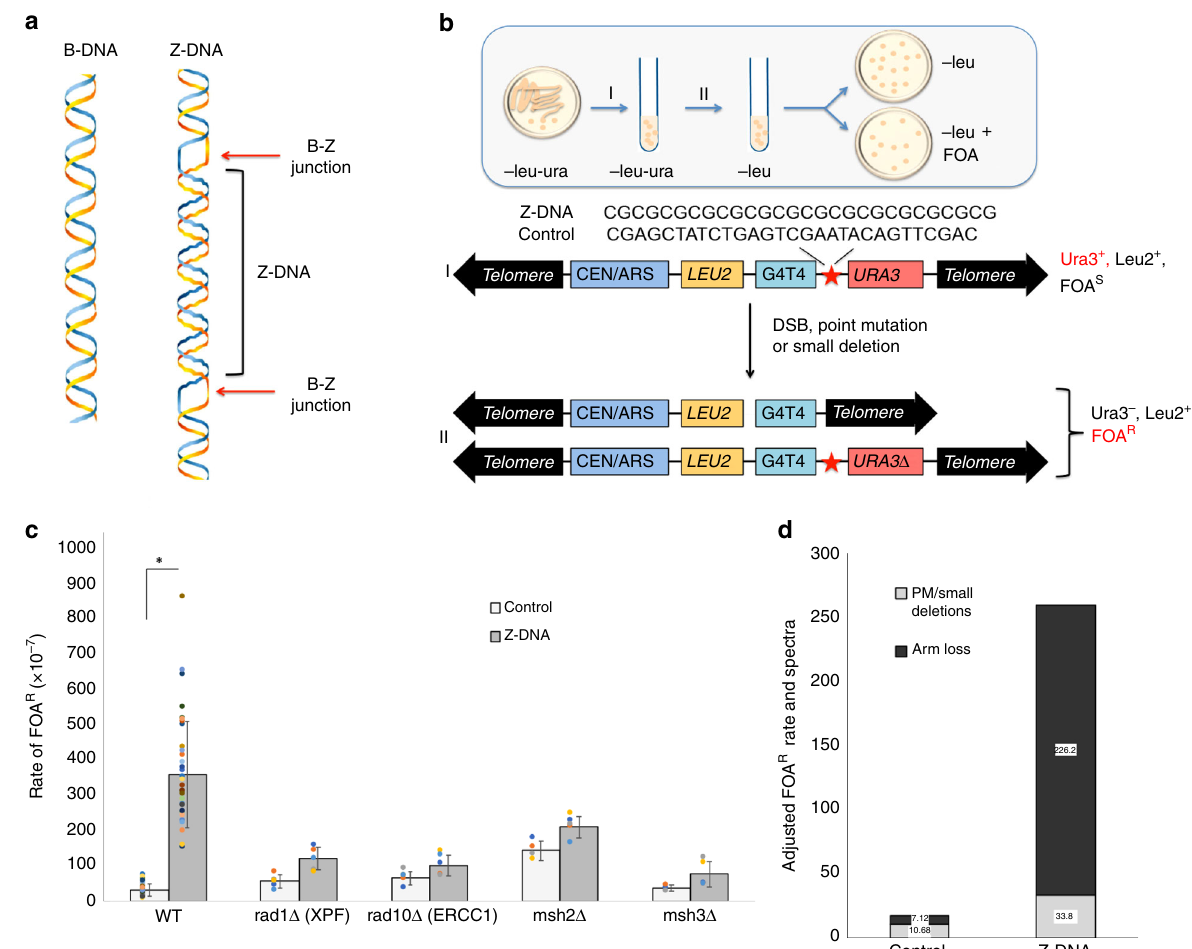
Fig. 1 Rad10-Rad1 and Msh2-Msh3 are required for Z-DNA-induced genetic instability in S. cerevisiae . a B-DNA (left panel) and left-handed Z-DNA fl anked by two regions of B-DNA (right panel) B-Z junctions are labeled (red arrows). b Schematic of the YAC fragility assay. c Mutation rates calculated as rate of FOA R for WT, rad1 Δ , rad10 Δ , msh2 Δ , and msh3 Δ strains containing control B-DNA or Z-DNA-forming YACs [Student ’ s t -test was used to calculate a P value. * P < 0.001]. Data are presented as means ± SEM of triplicate experiments, and values of each repeat are shown as dot plots on the bars. d Mutation spectra of FOA R clones from control B-DNA or Z-DNA-forming YACs in the WT strain were determined by sequencing and PCR, and mutants were categorized as either point mutation (PM)/small deletion within the URA3 gene or complete loss of the right arm of the chromosome as a result of a DSB 60 . “ Adjusted FOA R rate and spectra ” was calculated by multiplying the percentage of each category (calculated from 30 mutants) by the total FOA R ratio. See also Supplementary Figs. 1 and 2, and Supplementary Tables 1 and